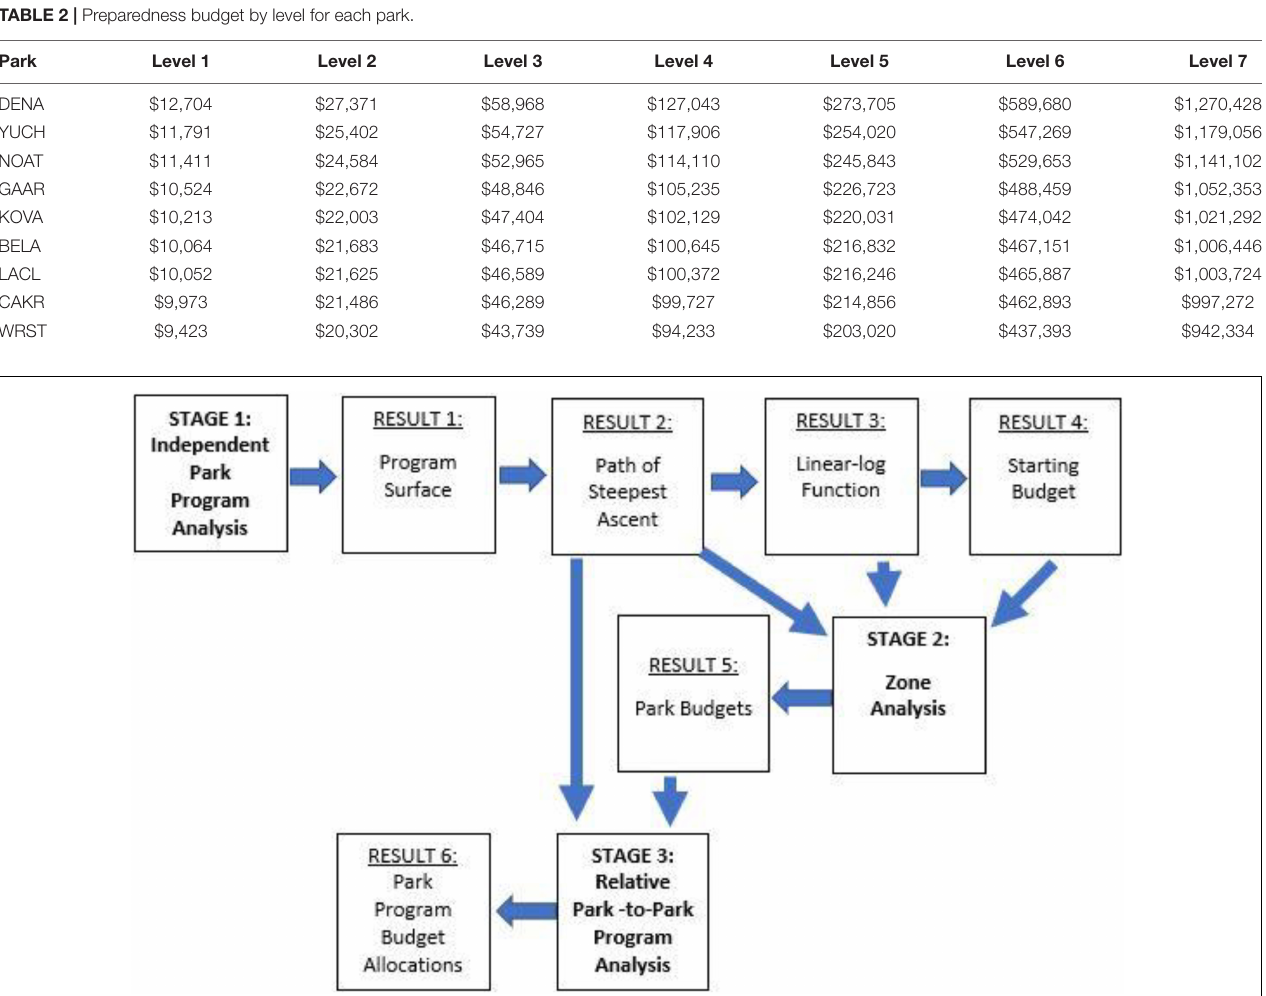
FIGURE 2 | Three stage process to produce results that can be used to allocate wildland fire program